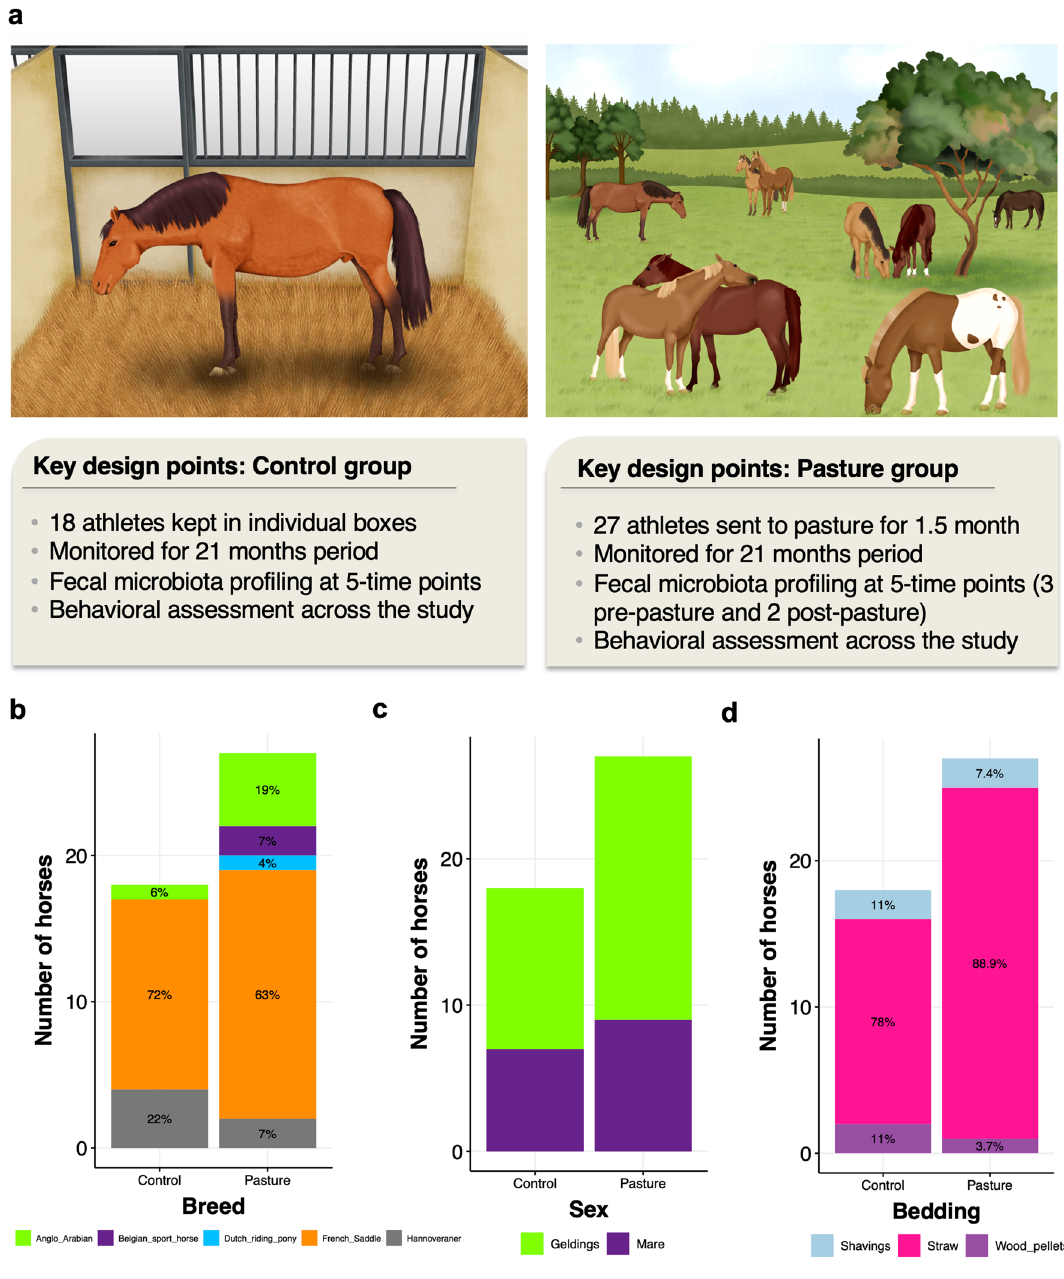
Figure 1. Description of the cohort. ( a ) Key points of the experimental design; ( b ) bar plot representing the number of individuals ascribed to each breed; ( c ) bar plot representing the number of individuals ascribed to each sex; ( d ) bar plot representing the number of individuals housed in straw bedding material, shavings or wood pellets. Written permission for publication of the drawing in the right panel of figure ( a ) has been given. The left pane of figure ( a ) has been obtained from Mach et al. 8 and used according to terms of a Creative Commons Attribution 4.0. License: http://creat iveco mmons .org/licen ses/by/4.0/. No changes were made. Plots b-d were produced in R software https ://www.r-proje ct.org, using the version